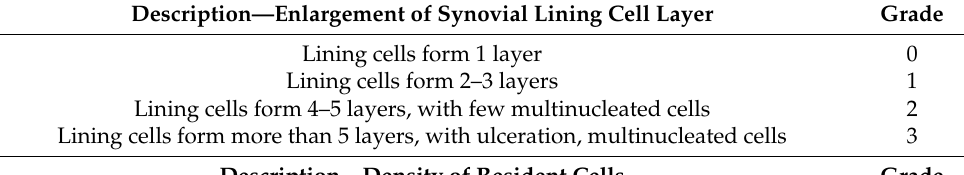
Table A4. Krenn synovitis scoring scale. Indications of thickening synovial lining cell layers, in- creased resident cell density, and inflammatory infiltrates were evaluated by three investigators. A consensus score was reported for each parameter.